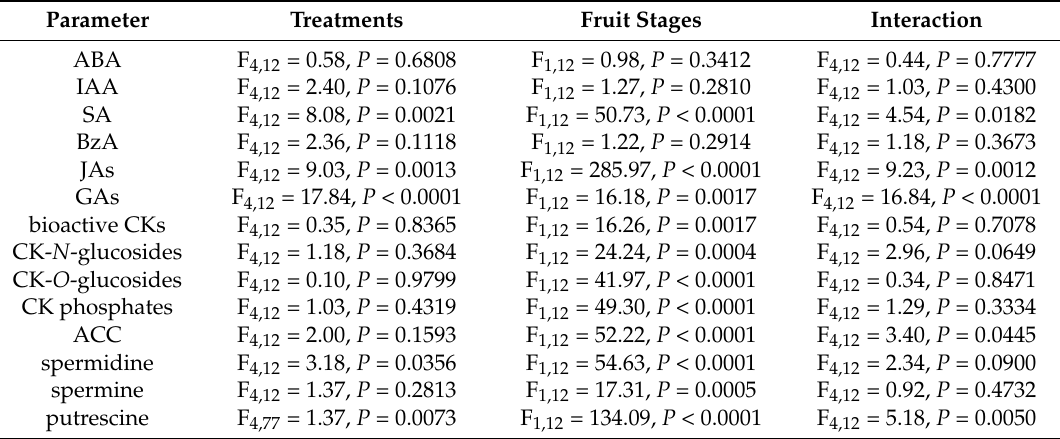
Table 5. Statistical results (ANOVA2) of endogenous phytohormone profile of early fruit development of intrinsic and extrinsic parthenocarpic ‘Conference’ pear